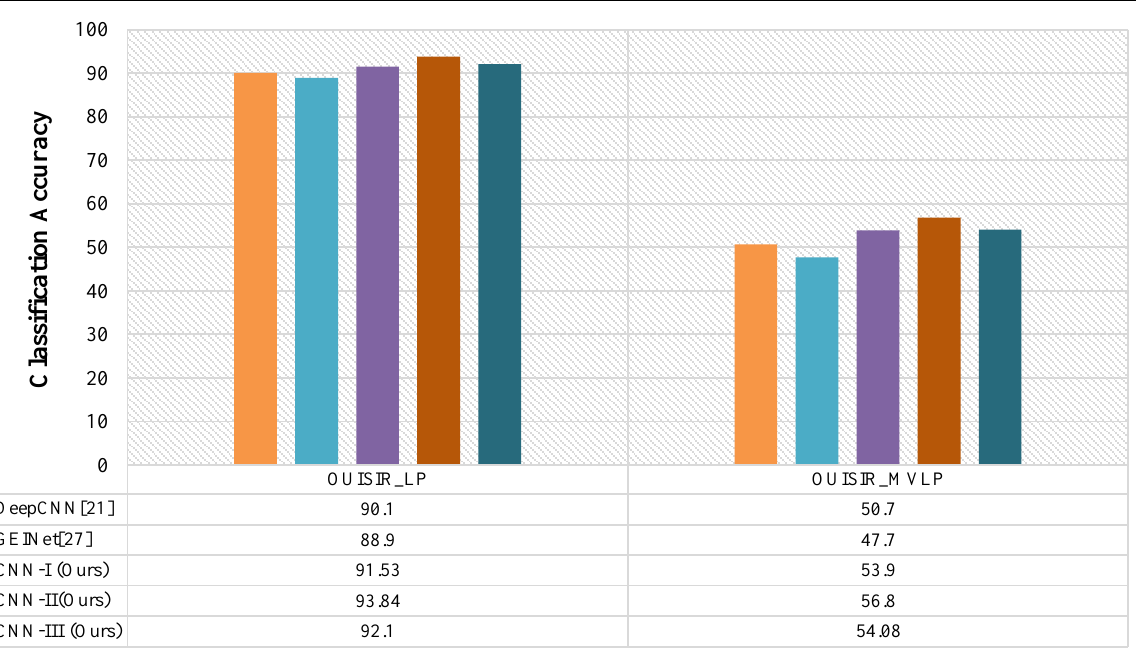
Figure 3. Comparison of CCR with Other